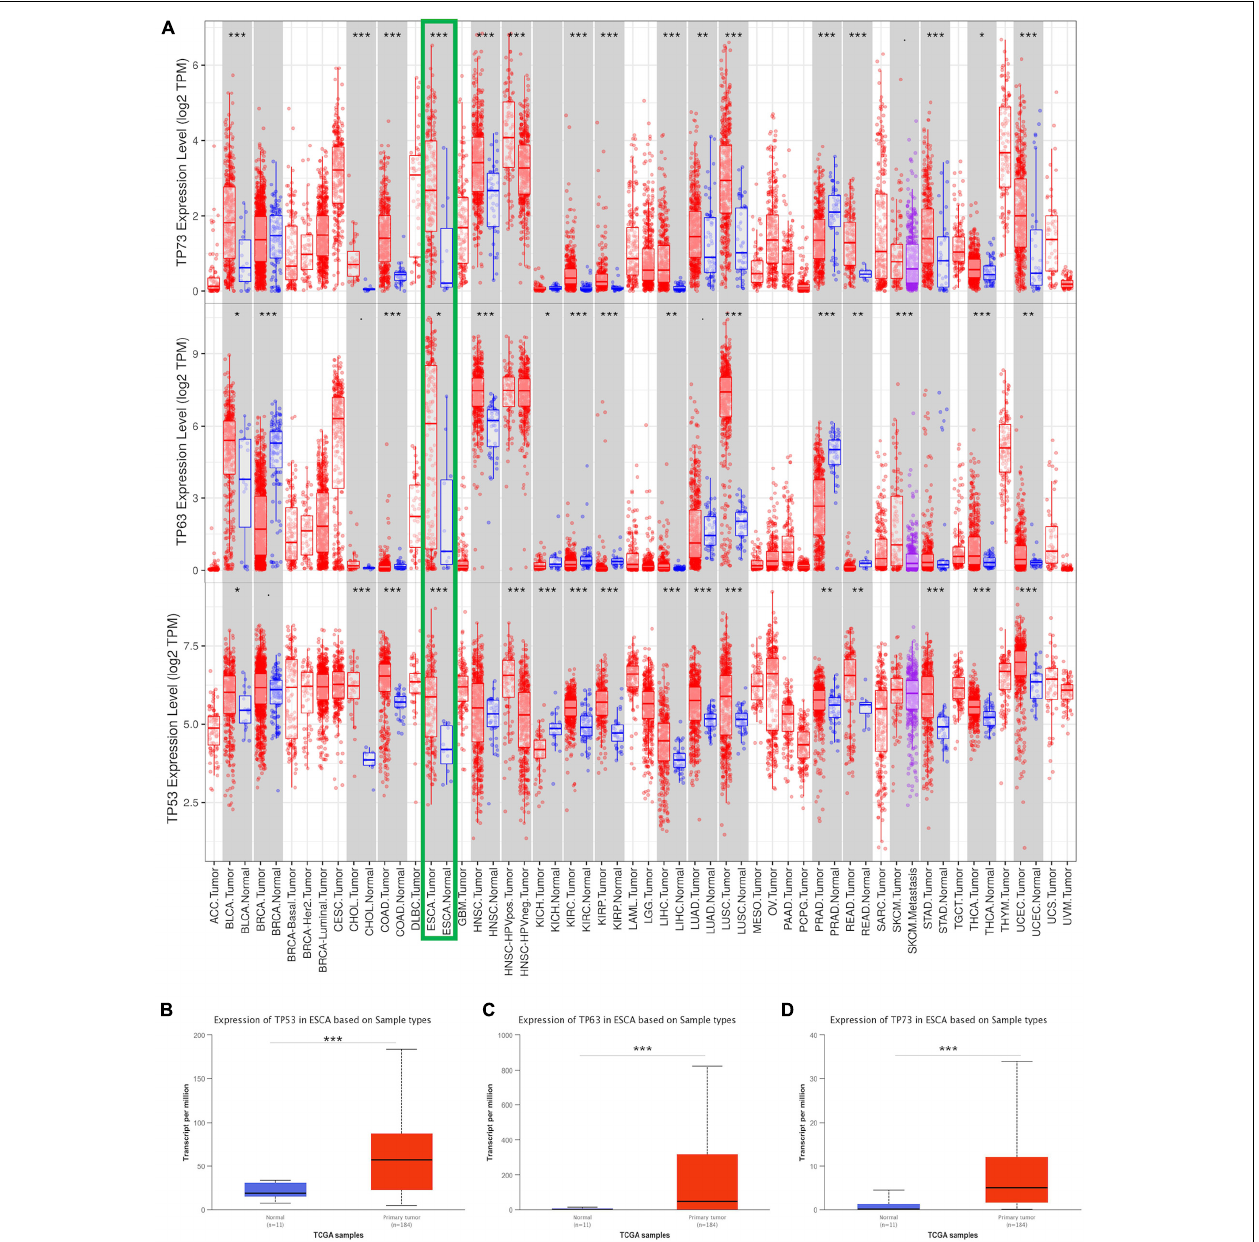
FIGURE 1 | Transcriptional expression of TP53 family member analysis. The mRNA levels of TP53 family members in 33 types of cancers from the TIMER database (A) . The expression of TP53 family members between ESCA and non-cancerous tissues from the TCGA (B–D) . * indicates p < 0.05, ** indicates p < 0.01, *** indicates p <